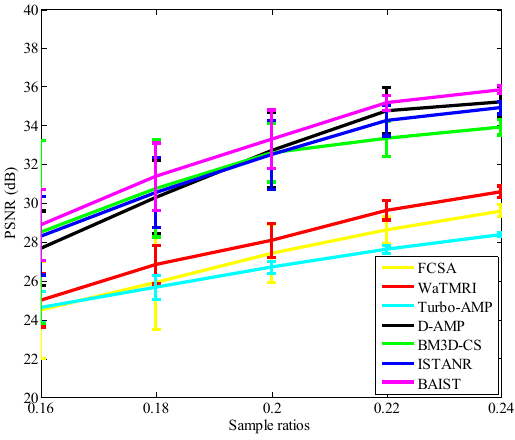
Figure 3. Average PSNR at different sample rates.